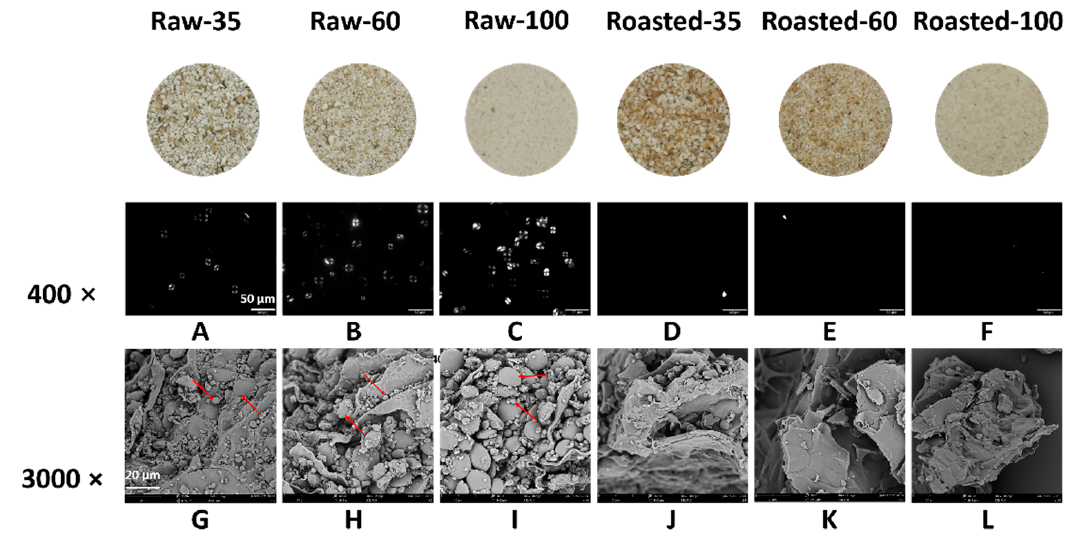
Figure 2. Images of polarized light microscope (PLM) and scanning electron microscope (SEM) of raw and sand-roasted highland barley flours. Raw-35, Raw-60, and Raw-100 indicate raw highland barley flour as coarse (250–500 µ m), medium (150–250 µ m), and fine (<150 µ m) fraction, respectively; while Roasted-35, Roasted-60, and Roasted-100 indicate sand-roasted highland barley flour as coarse (250–500 µ m), medium (150–250 µ m), and fine (<150 µ m) fraction, respectively. The scale bar in the PLM is 50 µ m ( A – F ) with magnification of 400 × ; the scale bar in the SEM is 20 µ m ( G – L ) with magnification of 3000 × . The red arrows in the SEM ( G – I ) figures present the morphology of starch granules with different particle sizes. ( A ) PLM of Raw-35. ( B ) PLM of Raw-60; ( C ) PLM of Raw-100; ( D ) PLM of Roasted-35; ( E ) PLM of Roasted-60; ( F ) PLM of Roasted-100; ( G ) SEM of Raw-35; ( H ) SEM of Raw-60; ( I ) SEM of Raw-100; ( J ) SEM of Roasted-35; ( K ) SEM of Roasted-60; ( L ) SEM of Roasted-100. The anisotropic structure color values of all samples are shown in Table 1.